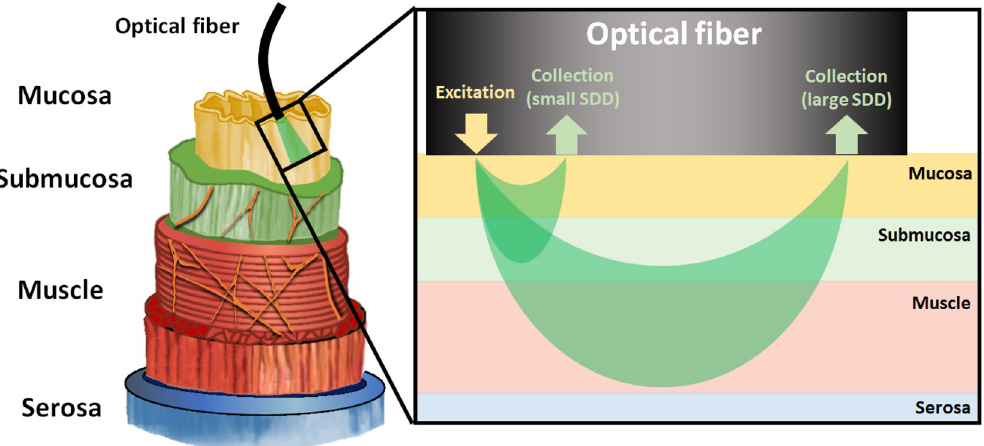
Figure 5. Tissue layers of the colon and rectum (left) and the light-tissue interaction volume interrogated by using the small SDD probe and the large SDD probe. The probed tissue depth increases with the SDD. Variations in the diffuse reflectance signal caused by carcinogenesis were evaluated based on the structural and biomolecular changes of the tissue layers investigated by each